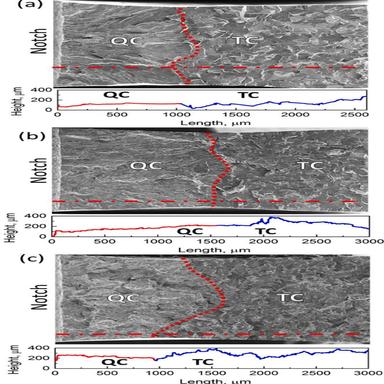
The entire views of the fracture surfaces of the technically pure iron – (a), Fe-2.5% Si alloy – (b) and low-carbon steel S235JR – (c) specimens underwent the full cycle of the two-step tensile testing. The diagrams below the SEM images represent the topographic profiles obtained by CLSM along the dash-dotted lines provided on the corresponding fractographic images. The dotted curves indicate the boundary between the QC and TC regions.